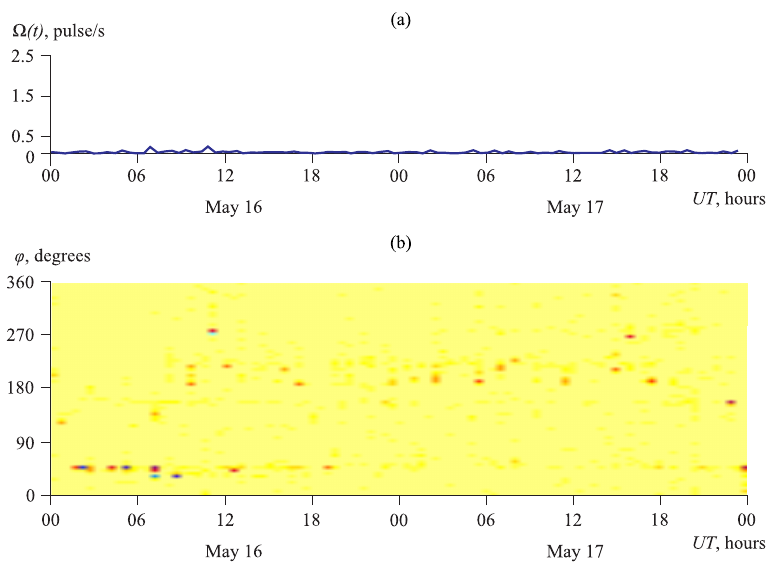
Figure 14. Seismically calm period on 16 and 17 May 2009: ( a ) acoustic activity Ω ( t ) and ( b ) its azimuthal distribution D ( ϕ , t ) . The color shows the number of detected pulses ascending from white to cyan.